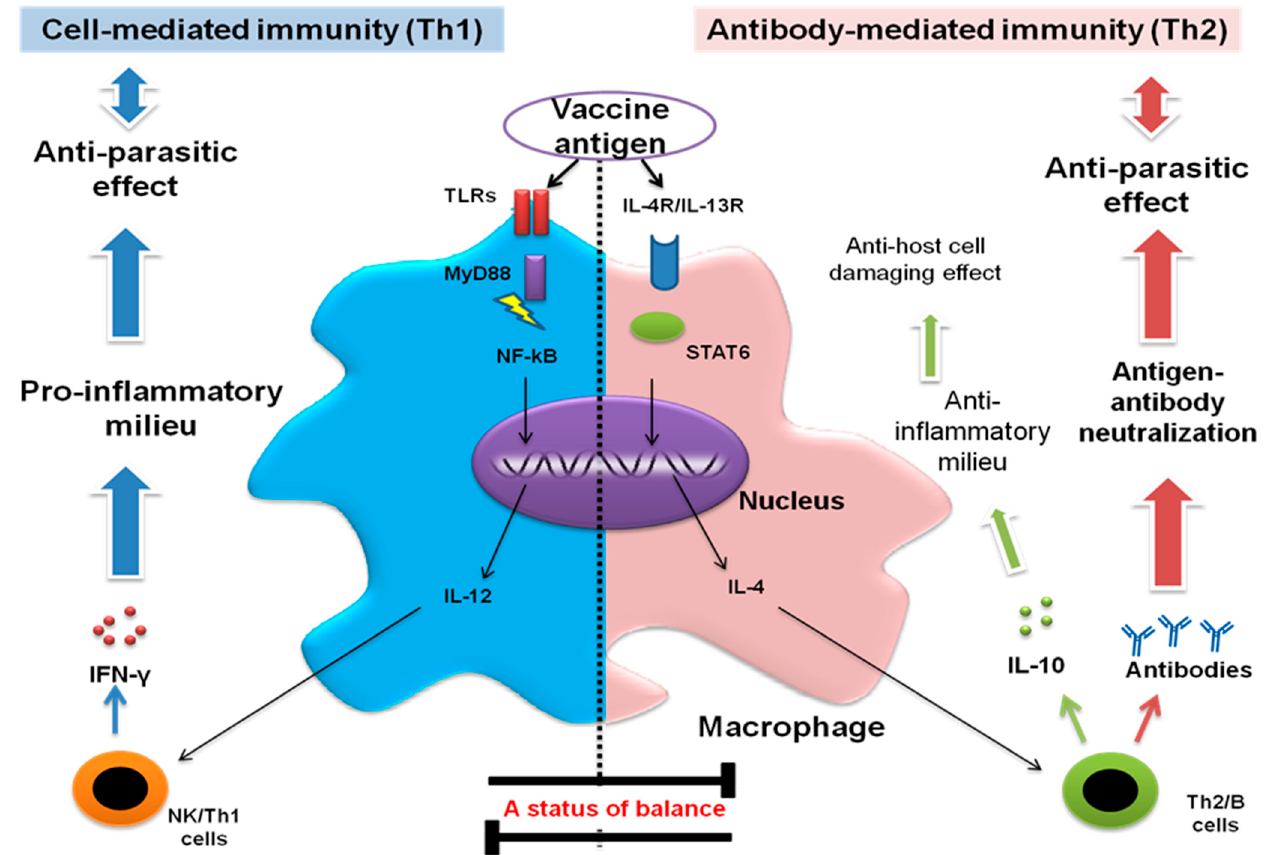
Figure 6. Contribution of macrophages in host protective immunity. Macrophages are the main source of IL-12 production. This cytokine is critical for IFN- γ production. TLRs, MyD88 and NF-kB are the efficient signaling pathway cascade toward the elimination of T. gondii or N. caninum via stimulating IFN- γ production from NK and Th1 cells. The positive feedback among IL-12 and IFN- γ result in the stimulation of Th1 cells and formation of IgG2 antibody, the main effectors for cell mediated immunity. In addition, Th2 mediated immunity participates in protective immunity. The secretion of IL-4 as feedback for IL-10 secretion also contributes to protective immunity either by secretion of regulatory (IL-10) or anti-inflammatory (IL-4) cytokines or through the specific antibody production. The balance between Th1 and Th2 immunity is important to prevent host cell damage from the cytokine storm effect or the excessive parasite